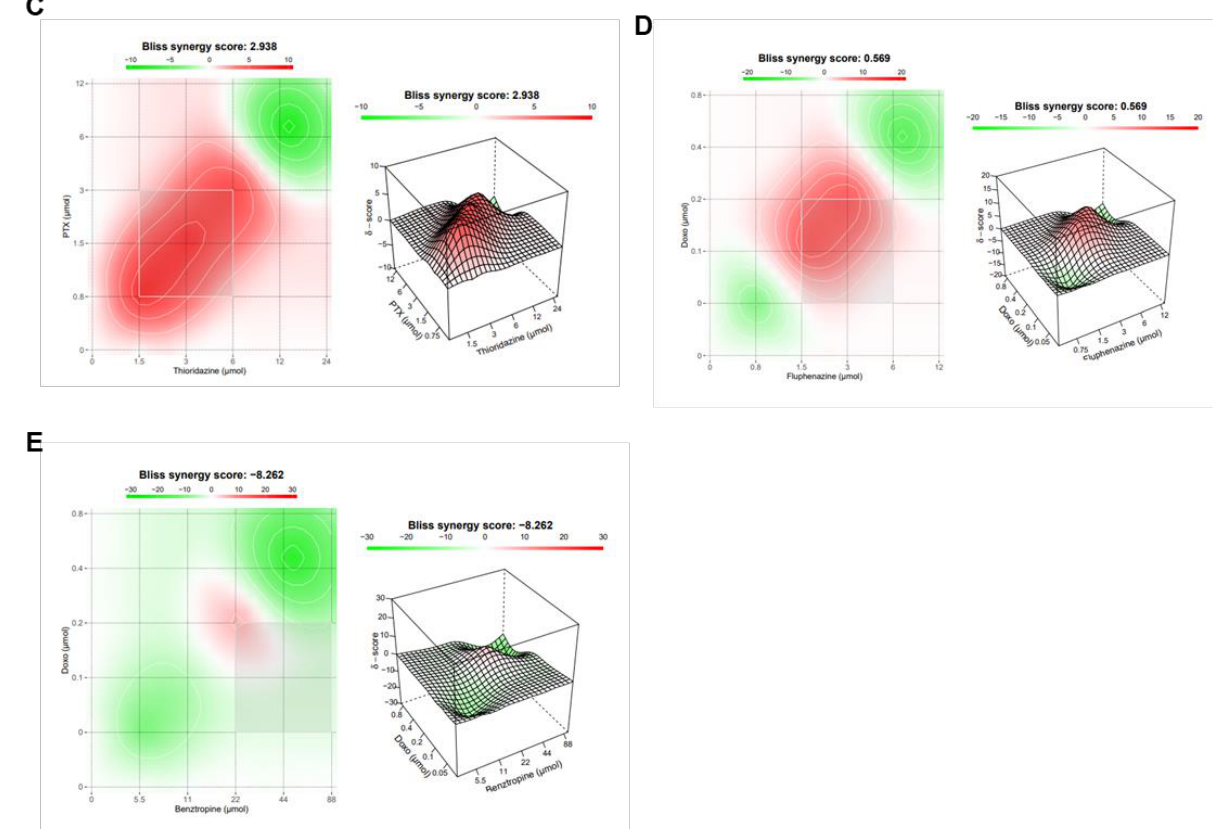
Figure 18. Bliss synergy plots of PTX plus fluoxetine ( A ), sertraline ( B ), thioridazine ( C ), fluphenazine ( D ) and benztropine ( E ).